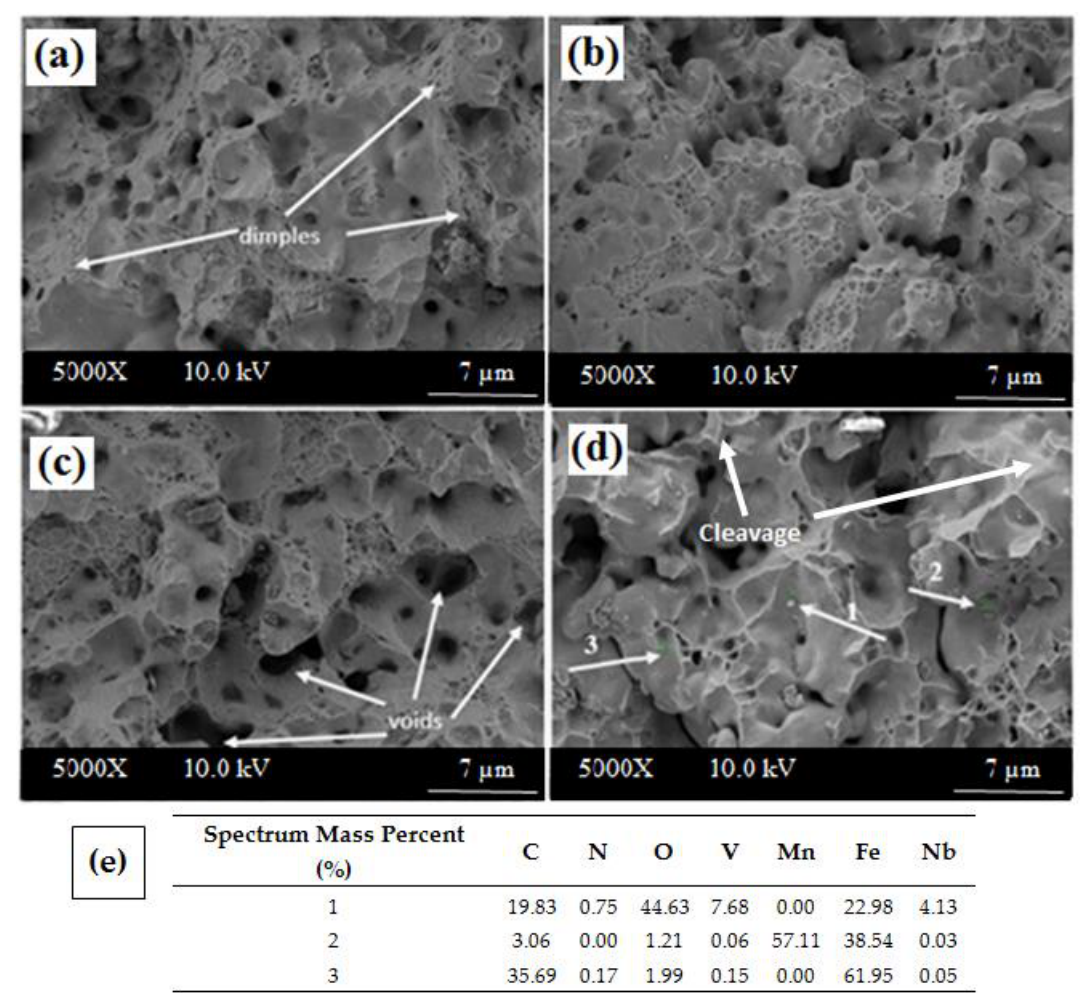
Figure 10. Fracture surfaces of microalloyed PM steels sintered at 1350 °C: ( a ) Alloy 1, ( b ) Alloy 2, ( c ) Alloy 3 and ( d ) Alloy 4. ( e ) EDS results from the indicated particle of Alloy 3.